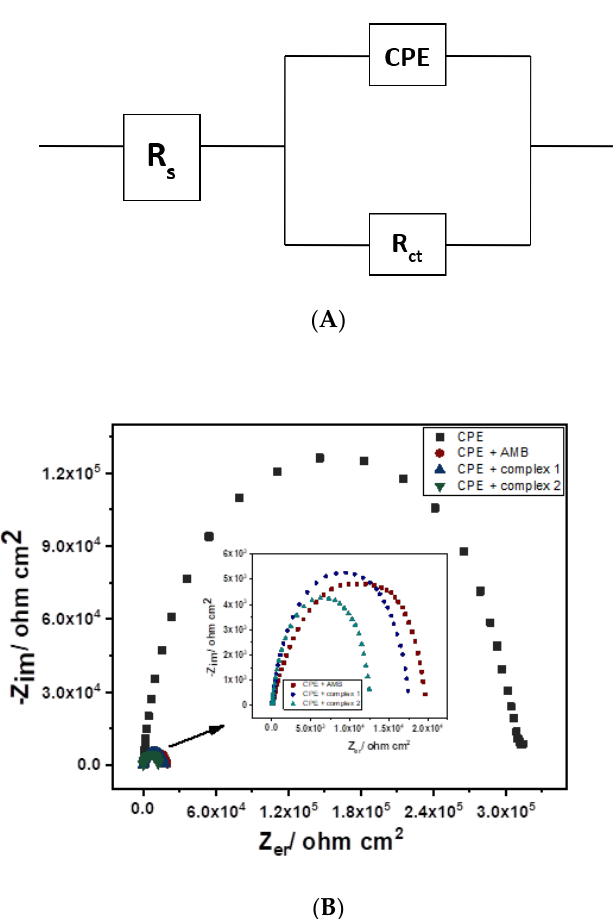
Figure 6. Equivalent circuit ( A ) and Nyquist plots ( B ) of bare CPE (a), CPE modified by AMB (b), CPE modified by Zn complex 1 (c) and CPE modified by Zn complex 2 (d) in a solution containing 1 mM [Fe(CN) 6 ] 3 − /4 − and 5 M